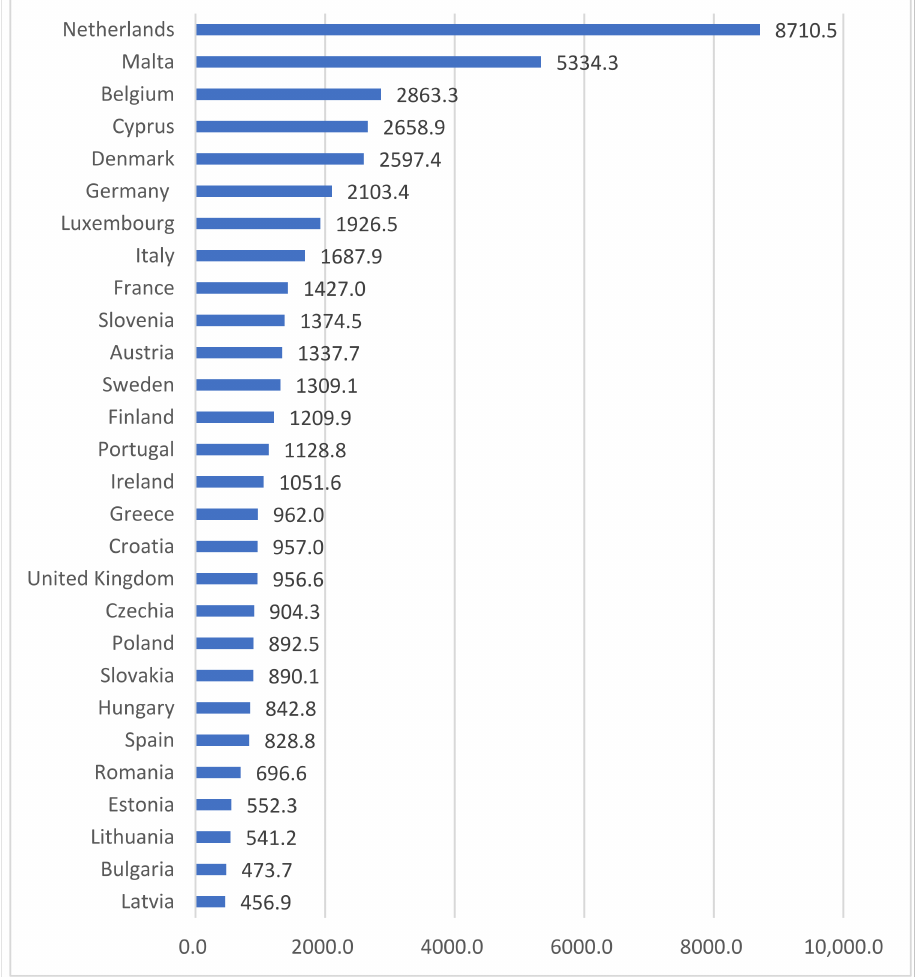
Figure 1. Intermediate consumption costs per hectare of utilized agricultural area (UAA) in the European Union countries, 2010–2019 (EUR per 1 ha). Source: own calculation The average value of the analyzed indicator in 28 member states of the EU from 2010 to 2019 was EUR 1667. Its level was higher than the EU mean in eight countries, and 13 did not exceed EUR 1000. The old and new member states can observe a clear difference in output intensity. In the analyzed period, the average value of intermediate consumption per 1 ha of utilized agricultural area in 13 new member states of the EU amounted to EUR 1275, while the mean for the EU-15 was EUR 2006.70. In countries such as Bulgaria, Latvia, Estonia, and Lithuania, production in the analyzed years was the least intensive. Poland incurred relatively low costs per 1 ha of UAA, accounting for 53.5% of those incurred in the EU (Figure 1). In each of the examined years, the coefficient of variation in the analyzed feature exceeded 100%, which means it was strongly diversified. At the same time, it can be seen that in 2010 the diversity was higher (105.4%) than in 2019